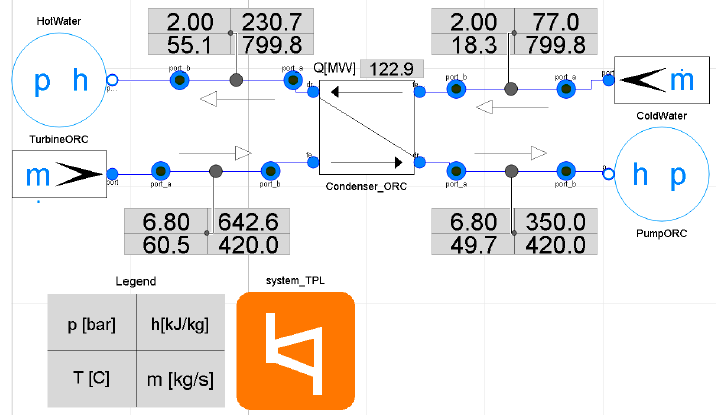
Figure 12. The model of the ORC condenser with R-600a working medium.